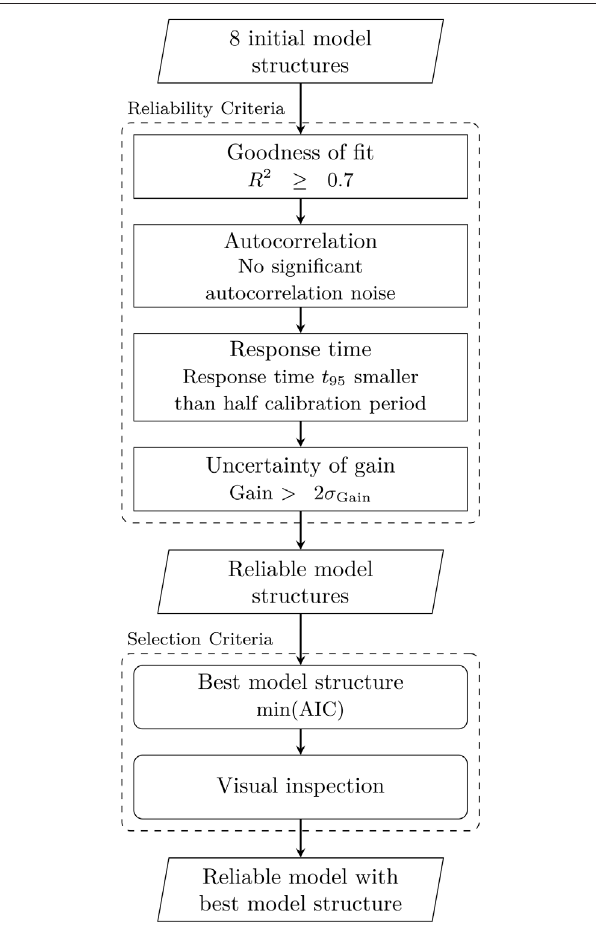
FIGURE 2 | Criteria for reliable models and selection of best model